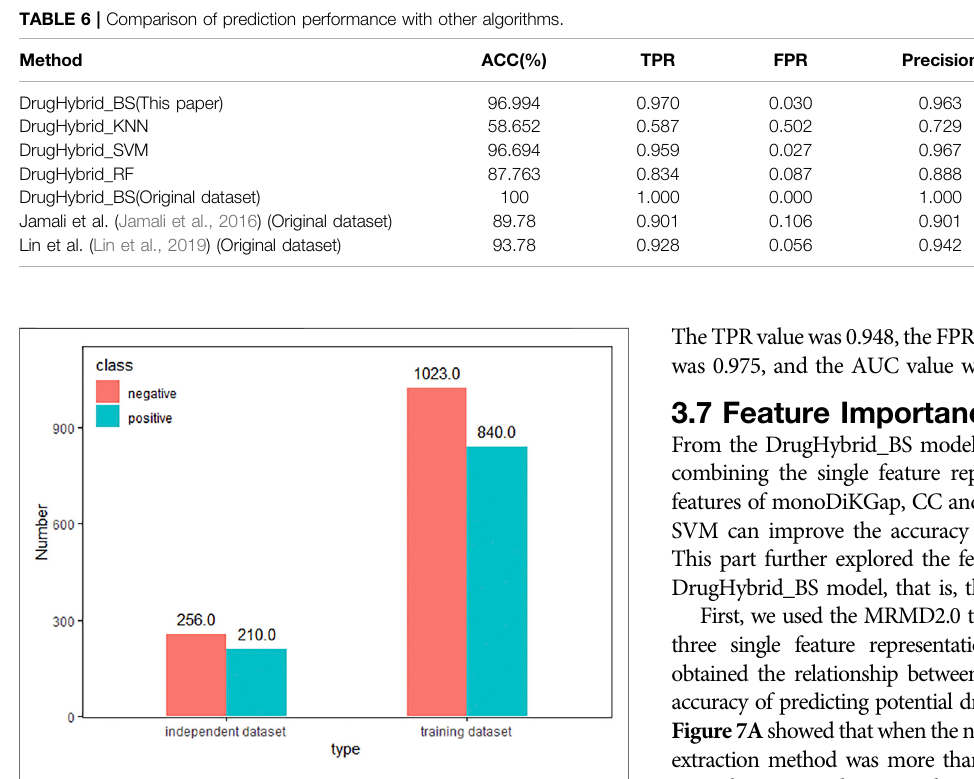
FIGURE 6 | Details of the training set and independent test set.